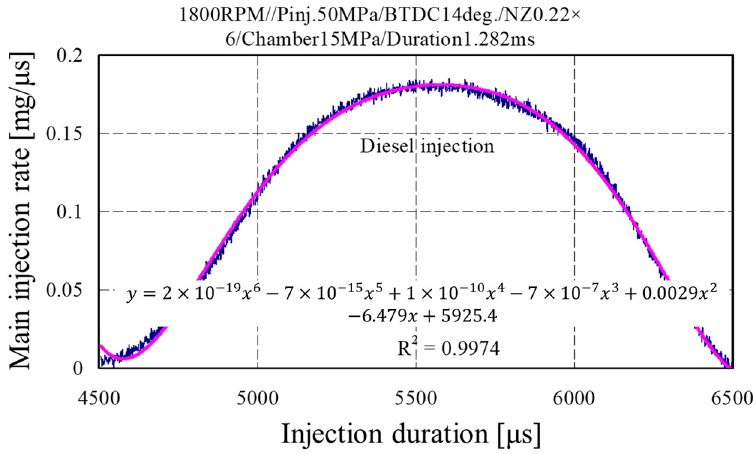
Figure 13. Injection rate characteristic for only the main injection quantity of the pilot and main injection durations for diesel.